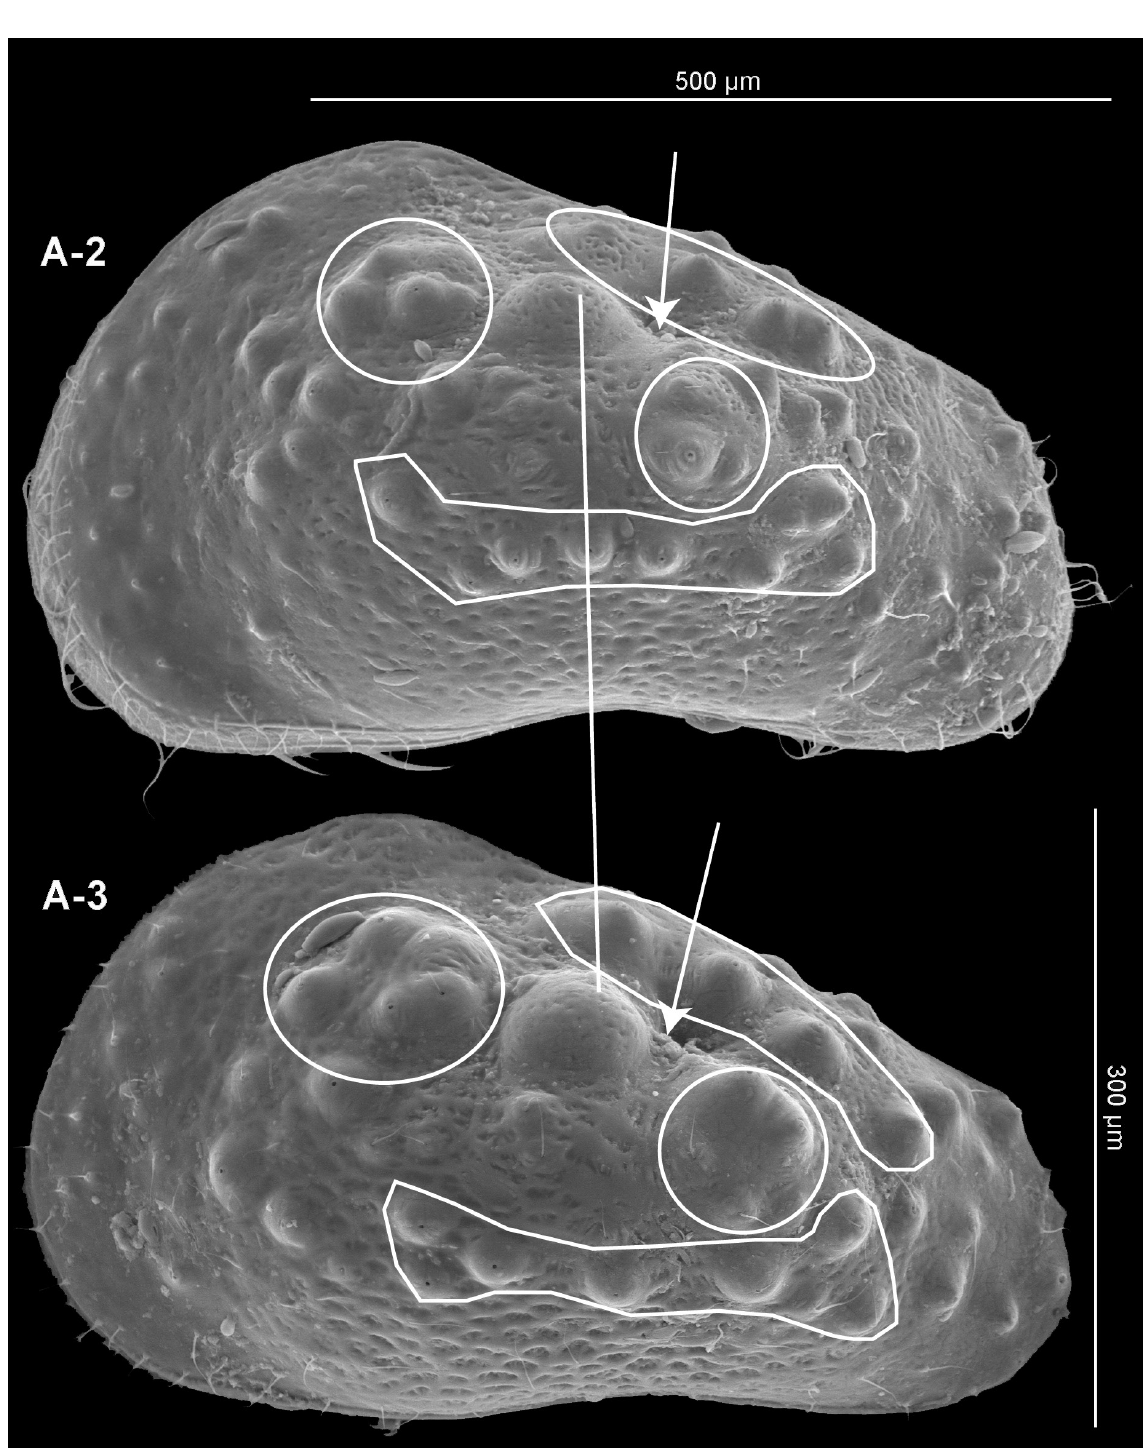
Fig. 8. External views of carapaces of Bennelongia cf . nimala nov. sp. juveniles from Muggon Lake, showing left valves in order to compare the ornamentation between an A-2 specimen (top) and A-3 specimen (bottom). The circles, ellipses and polygons are used to define the ornamentations that are common to both specimens. The arrows indicate a clear depression, postero-dorsally to each dome, that are linked by a white